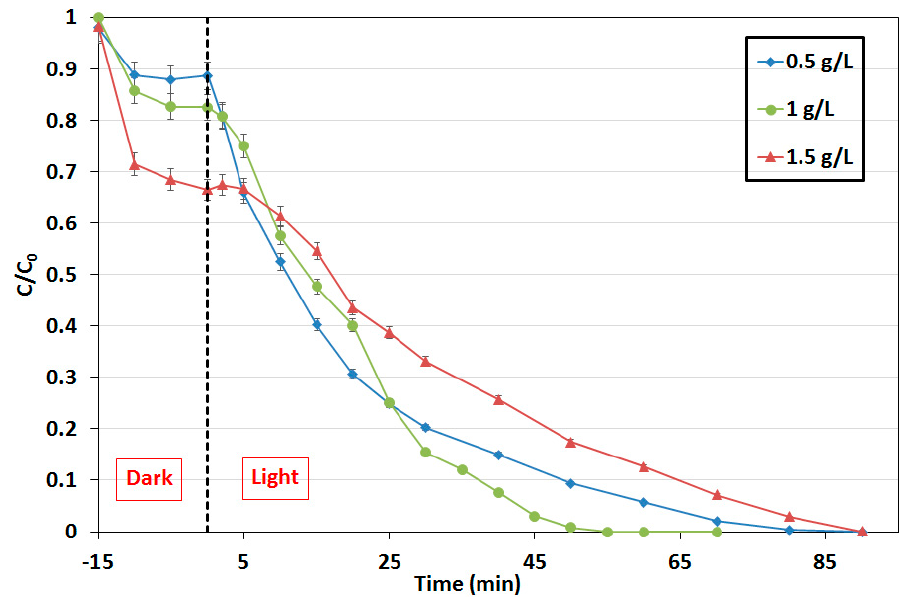
Figure 3. Influence of the TiO 2 photocatalyst mass for the degradation of MB in aqueous solution (C 0 = 60 mg/L; pH neutral; temperature = 20 ± 2 ◦ (C0 = 60 mg/L; pH neutral; temperature = 20 ± 2 °C).